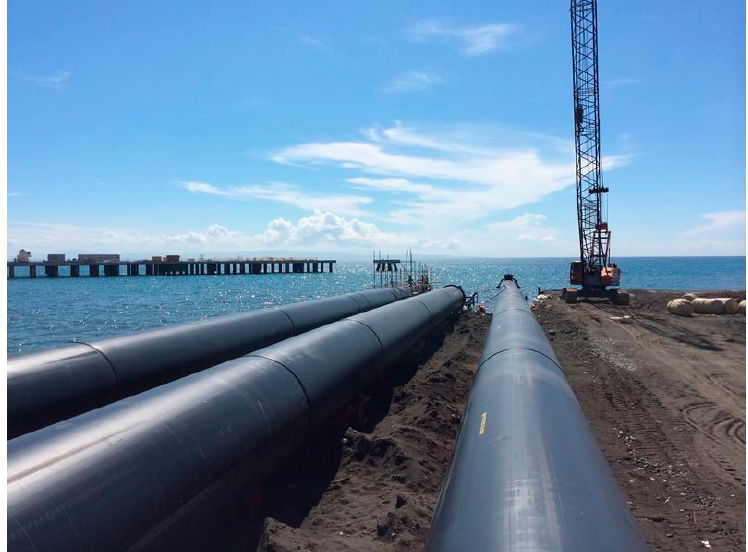
Figure 4. Water transfer project from the Persian Gulf to the province of Kerman [35].